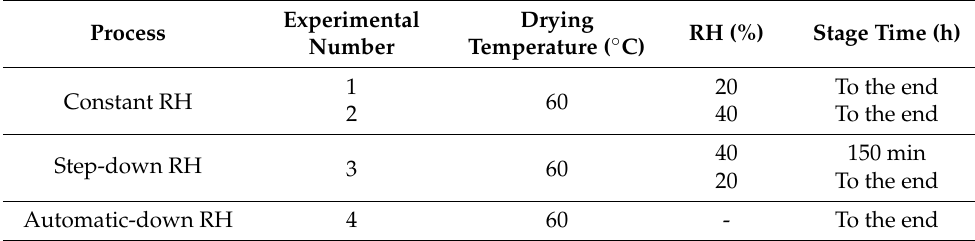
Table 2. Experimental design and experimental